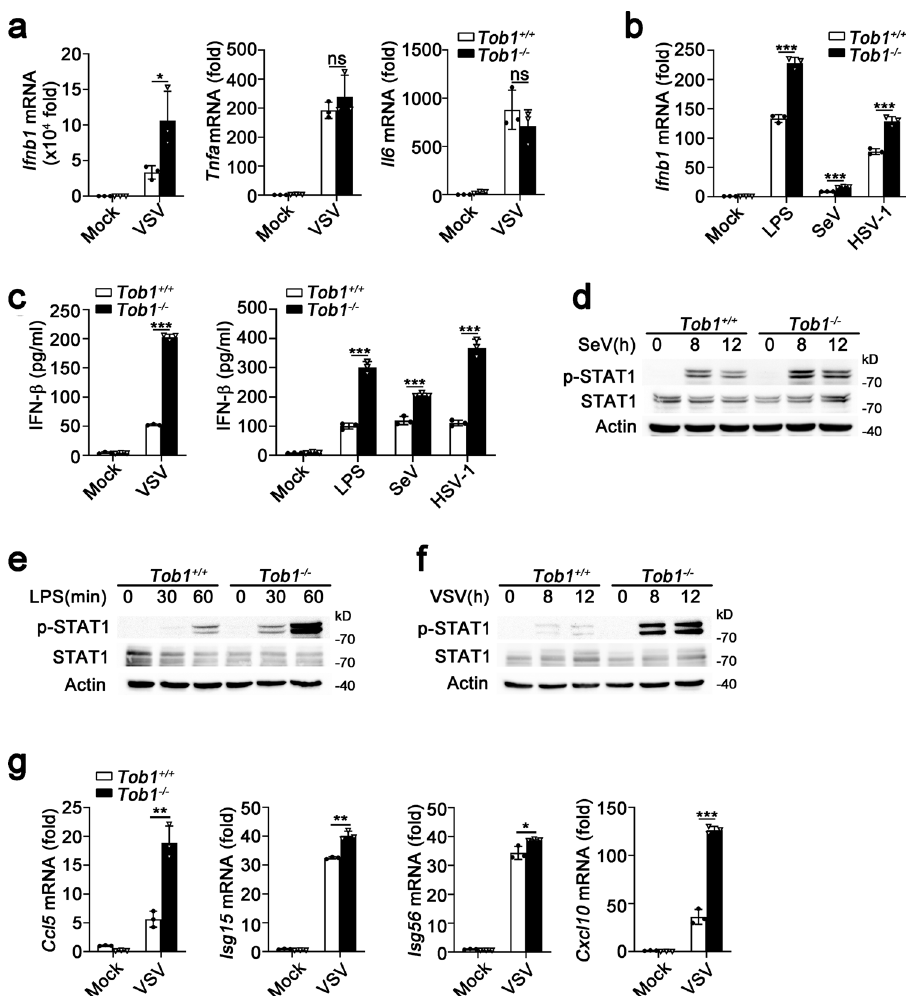
Fig. 2 Tob1 de fi ciency enhances IFN- β expression. a Quantitative real-time RT-PCR analysis of IFN- β , TNF- α , and IL-6 mRNA expression in peritoneal macrophages (PMs) isolated from Tob1 + / + or Tob1 − / − mice and then infected with VSV. b Quantitative real-time RT-PCR analysis of IFN- β mRNA expression in PMs isolated from Tob1 + / + or Tob1 − / − mice and then exposed to lipopolysaccharide (LPS) or infected with SeV or HSV-1. c Enzyme-linked immunosorbent assay (ELISA) of IFN- β secretion in the supernatants of PMs from Tob1 + / + or Tob1 − / − mice after treatment as indicated. d – f Western blot analysis of STAT1 phosphorylation in PMs isolated from Tob1 + / + or Tob1 − / − mice and then exposed to SeV ( d ), LPS ( e ), or VSV ( f ). g Quantitative real- time RT-PCR analysis of Ccl5, Isg15, Isg56 , and Cxcl10 mRNA expression PMs isolated from Tob1 + / + or Tob1 − / − mice and then infected with VSV. All data are shown as the means ± SD. Signi fi cance was determined by unpaired two-tailed Student ’ s t -test: * p < 0.05, ** p < 0.01, *** p < 0.001, ns, p > 0.05. Data are shown as a representative result from three independent experiments. Data are shown as a representative result from three independent